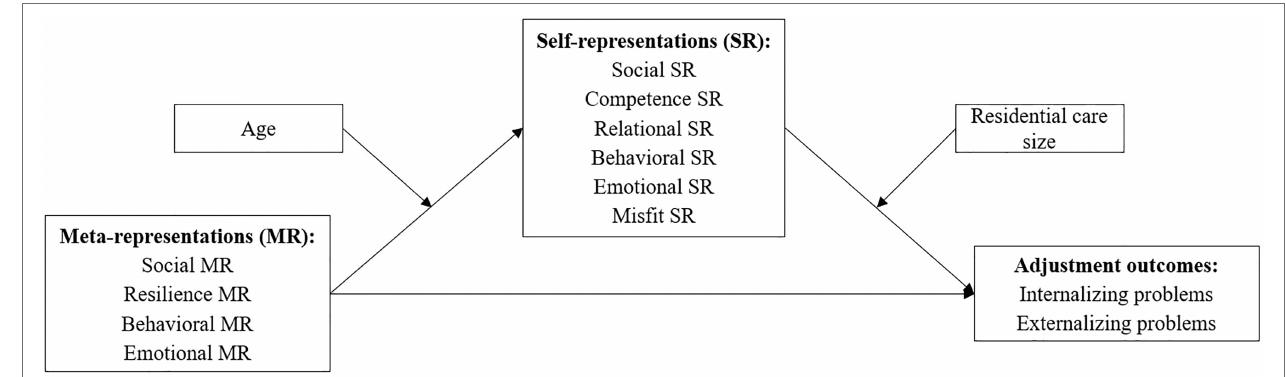
FIGURE 1 | Theoretical model summarizing the predicted relationships between